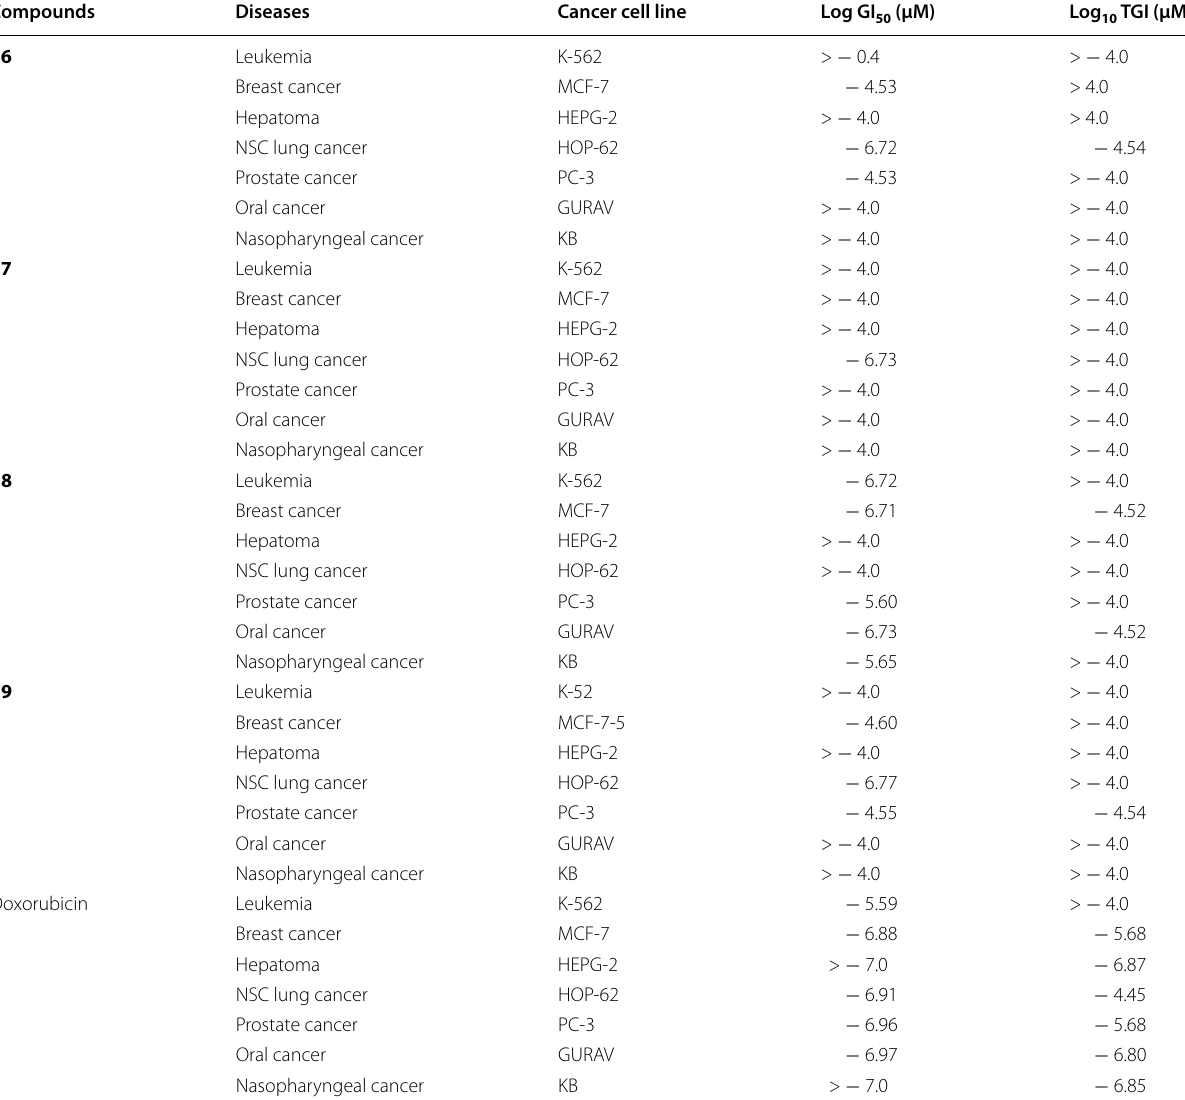
Table 25 Anti-tumor activities of synthesized derivatives in different cell lines Compounds